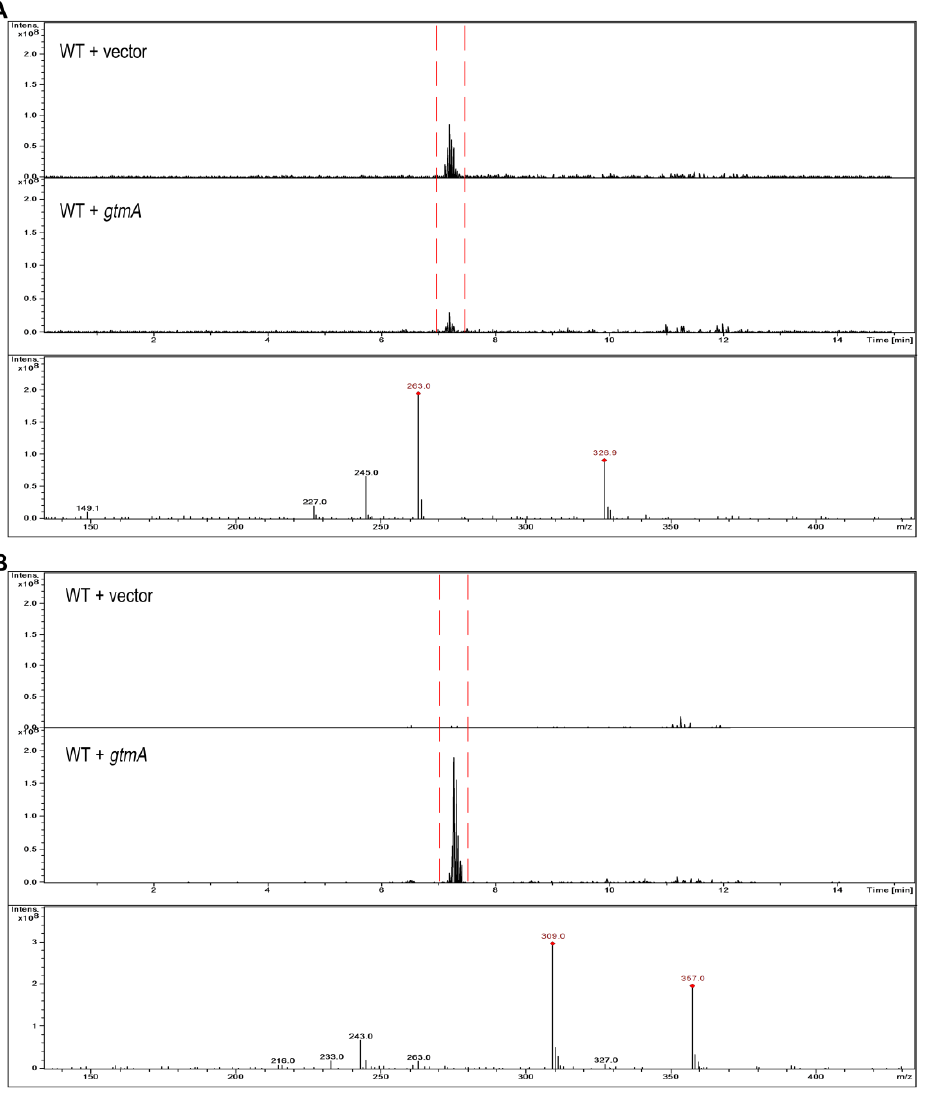
FIGURE 3: Detection and monitoring of GT and BmGT in yeast using mass spec- readily detected in supernatants of